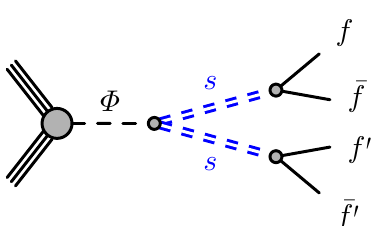
Figure 1. A diagram showing the Φ → ss → f ¯ ff 0 ¯ f 0 decay used as the benchmark model. The s inherits Yukawa couplings to SM fermions from the Φ , and therefore decays primarily to heavy